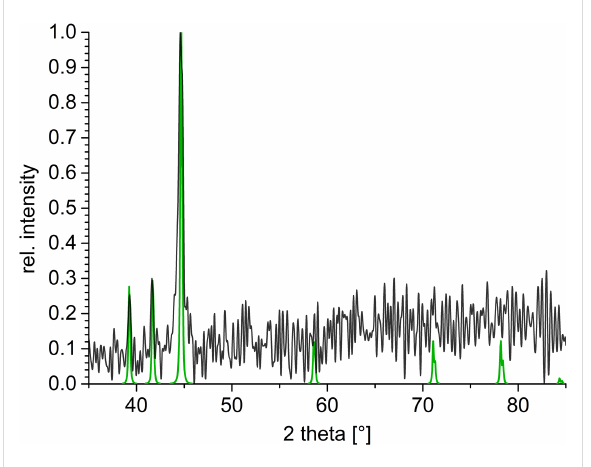
Figure 1: P-XRD pattern of Ni@rGO obtained from a 0.5 wt % disper- sion of Ni(COD) 2 in [BMIm][NTf 2 ] (space group of nickel: P 6 3 / mmc